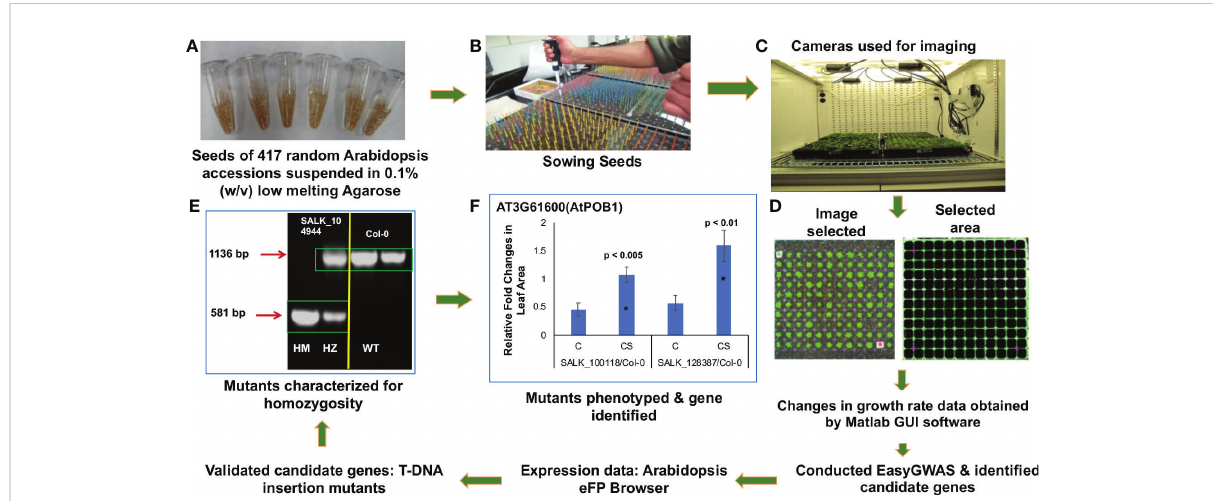
FIGURE 1 Schematic representation of the steps in identifying genes involved in cold stress using a high-throughput phenotyping platform. After suspending in low melting agarose (A) , seeds were strati fi ed, and sown (B) , and grown in the Arabidopsis growth chambers fi tted with digital cameras (C) . Two- dimensional images of the rosette leaves of individual genotypes were captured and analyzed using Matlab GUI software (Method S2) (D) . The digital images were converted to pixel data for easyGWAS to identify putative cold-stress-related genes. The candidate cold-stress-related genes were validated by studying knockout mutants. Homozygous knockout mutants were identi fi ed (E) . SALK_104944, knockout T-DNA insertion mutant for AT1G68320; HM, homozygous line; HZ, heterozygous line; WT (Col-0 ecotype), wild-type with no insertion. Knockout mutants were phenotyped to determine if any of the 33 putative cold-stress-related genes play a role in chilling tolerance (F)